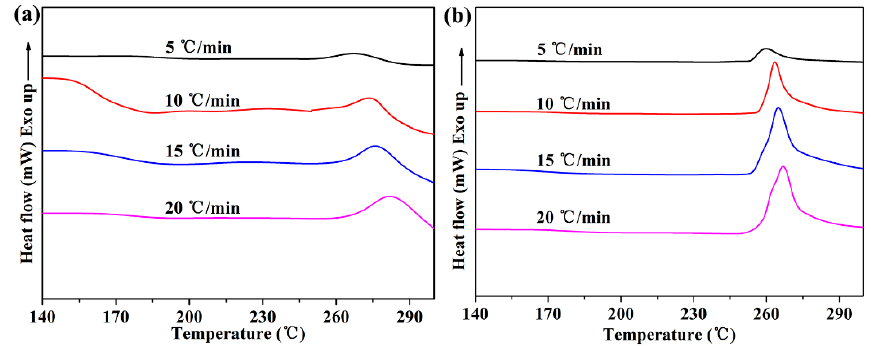
Figure 5. The effects of the heating rate on the cold crystallization temperature of neat PEN ( a ) and PEN nanocomposite with 2 wt% h-BN@(PDA + PEI) ( b